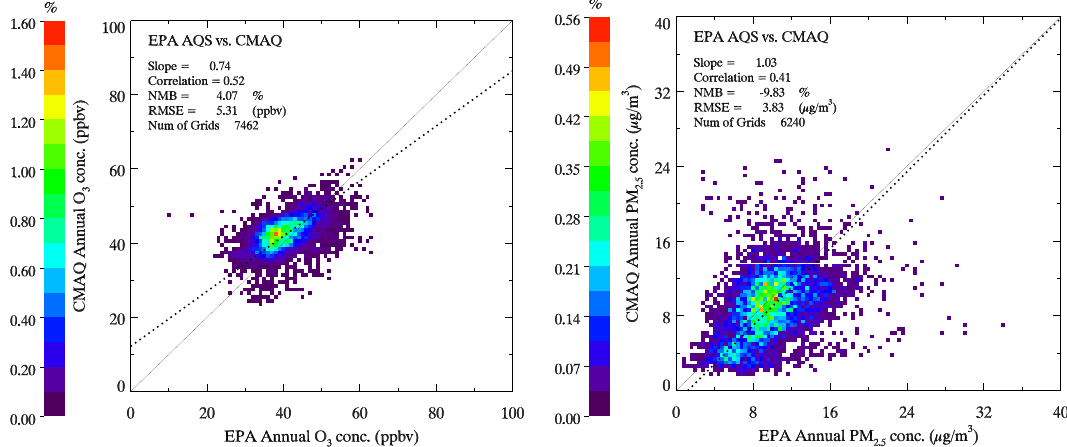
Figure 4. Comparisons of annual-mean surface O 3 ( left ) and PM 2.5 ( right ) between community multiscale air quality (CMAQ) modeled results and air quality system (AQS) observations over the years of 2000-2016. Each point represents a paired simulated and measured data in time and space. The color bar shows the scatter density (%) of measured vs. modeled O 3 ( left , in 1 ppbv bin) and PM 2.5 ( right , in 0.4 µ g m − 3